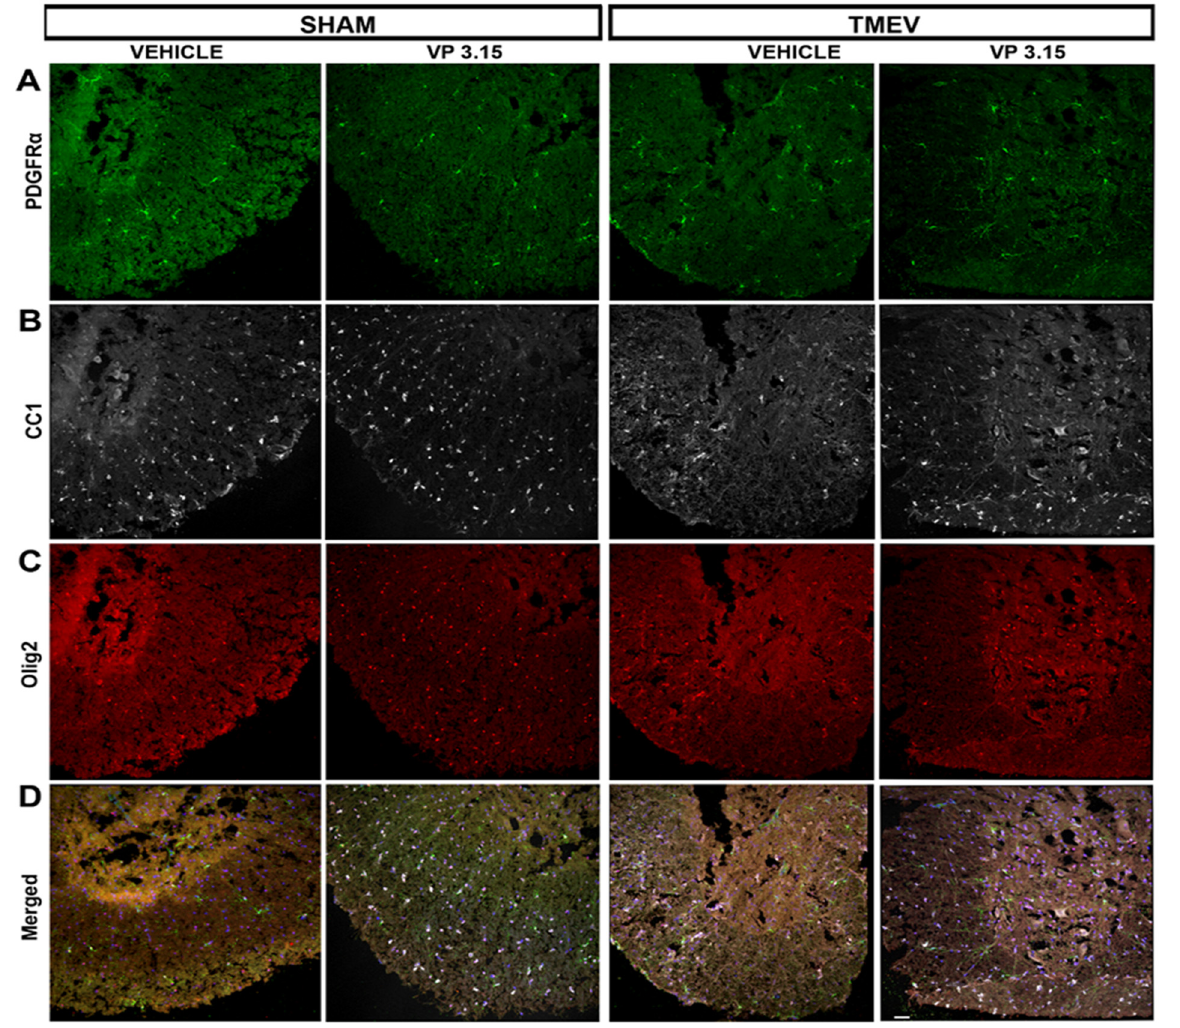
Figure 4. The VP3.15 promotes the presence of mature oligodendrocytes in spinal cord. ( A – D ): De- tailed views of the spinal cords of vehicle and VP3.15-treated mice, labeled for PDGFR α (green), Olig2 (red), CC1 (grey) and merged includes nuclei (Hoechst; blue). Scale bar represents 50 µm. ( E , F ): Graphs are showing the significant increase in the percentage of PDGFR α + Olig2 + cells (E) and Olig2 + CC1 + cells ( F ) after the treatment with VP3.15 compared to the vehicle. The statistical analysis was performed using the Student’s t test, with the following values: ** p < 0.01 Sham versus TMEV-